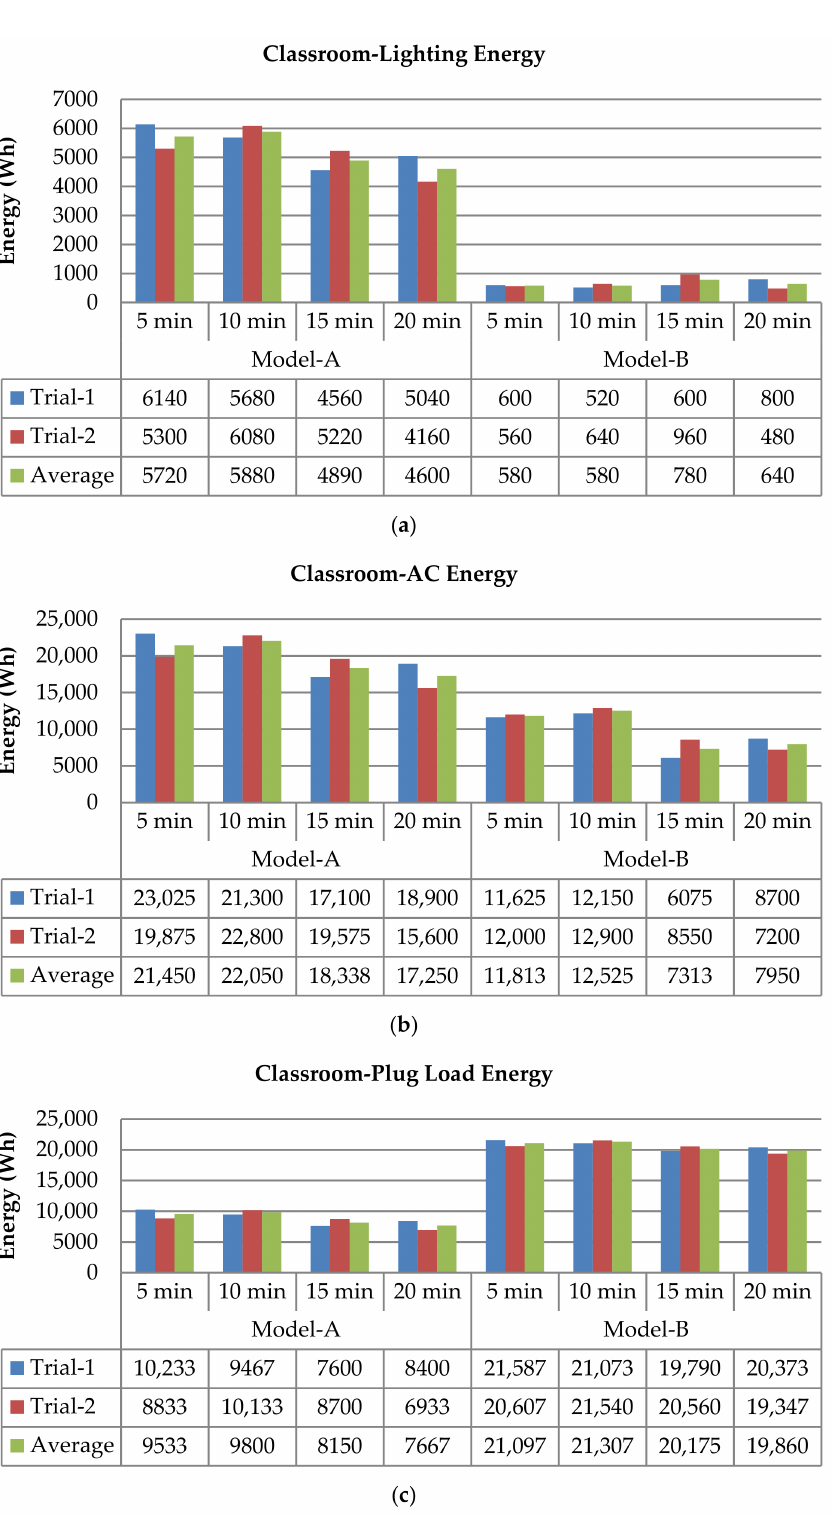
Figure 12. Energy consumption in the Classroom: ( a ) lighting energy; ( b ) AC energy; ( c ) plug load